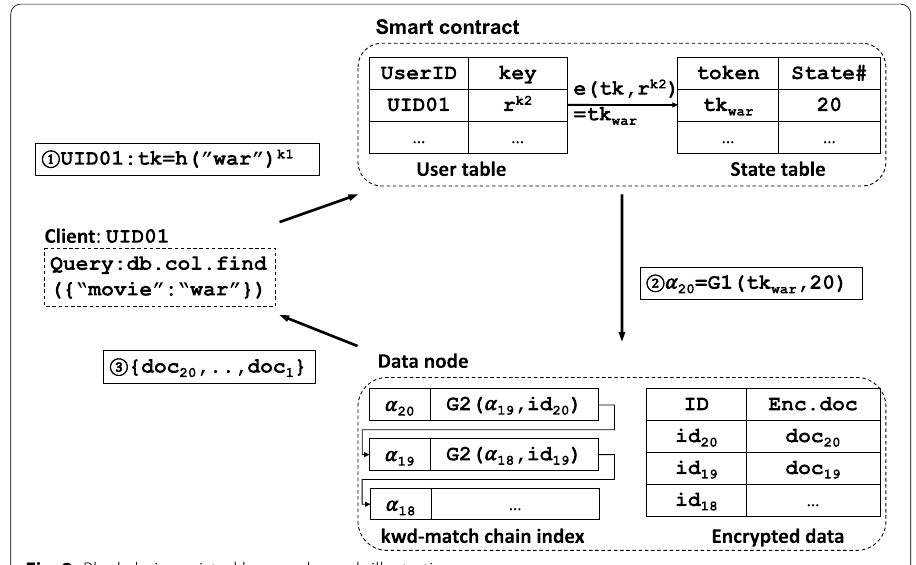
Fig. 2 Blockchain-assisted keyword search